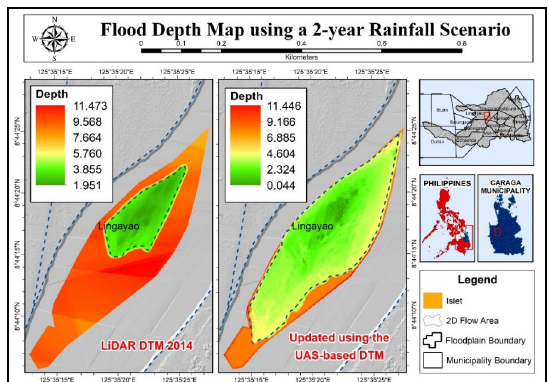
Figure 19. Comparison of flood depth maps using the existing LiDAR DTM and the updated data using UAS during the 2-year Rainfall